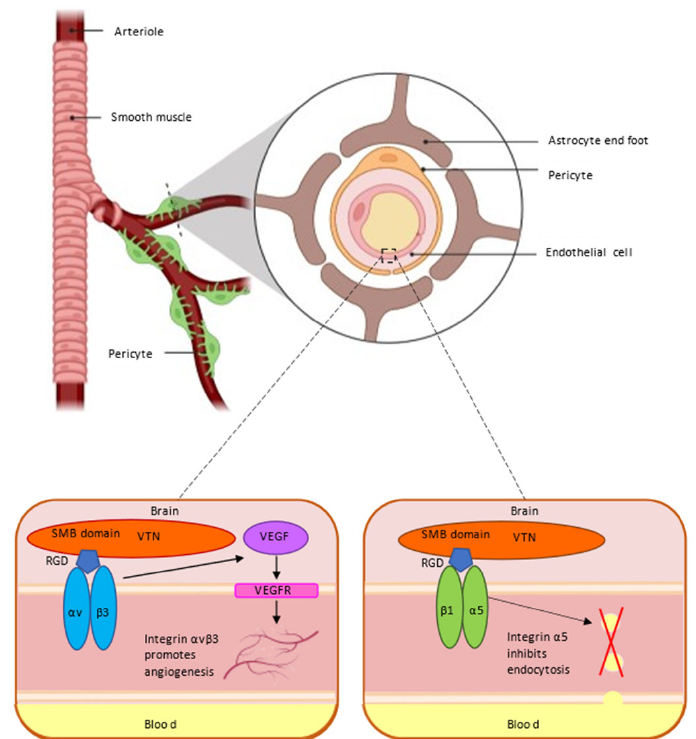
Figure 3. A schematic illustration depicting how VTN and its receptors α v β 3 and α 5 β 1 affect blood–brain barrier. On the left, VTN by binding to α v β 3 can activate VEGF, which regulates angiogenesis by binding to VEGFR on the surface of cell membranes. On the right, integrin α 5 can inhibit endocytosis of endothelial cells to ensure the integrity of barrier function and protect the brain. Adapted from “Brain Vascular System”, by BioRender.com (2022). Retrieved from https://app.biorender.com/biorender ‐ templates (accessed on 27 August 2022).